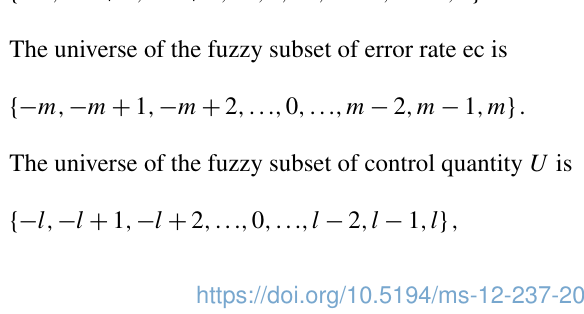
Figure 7. Schematic diagram of polishing force control.